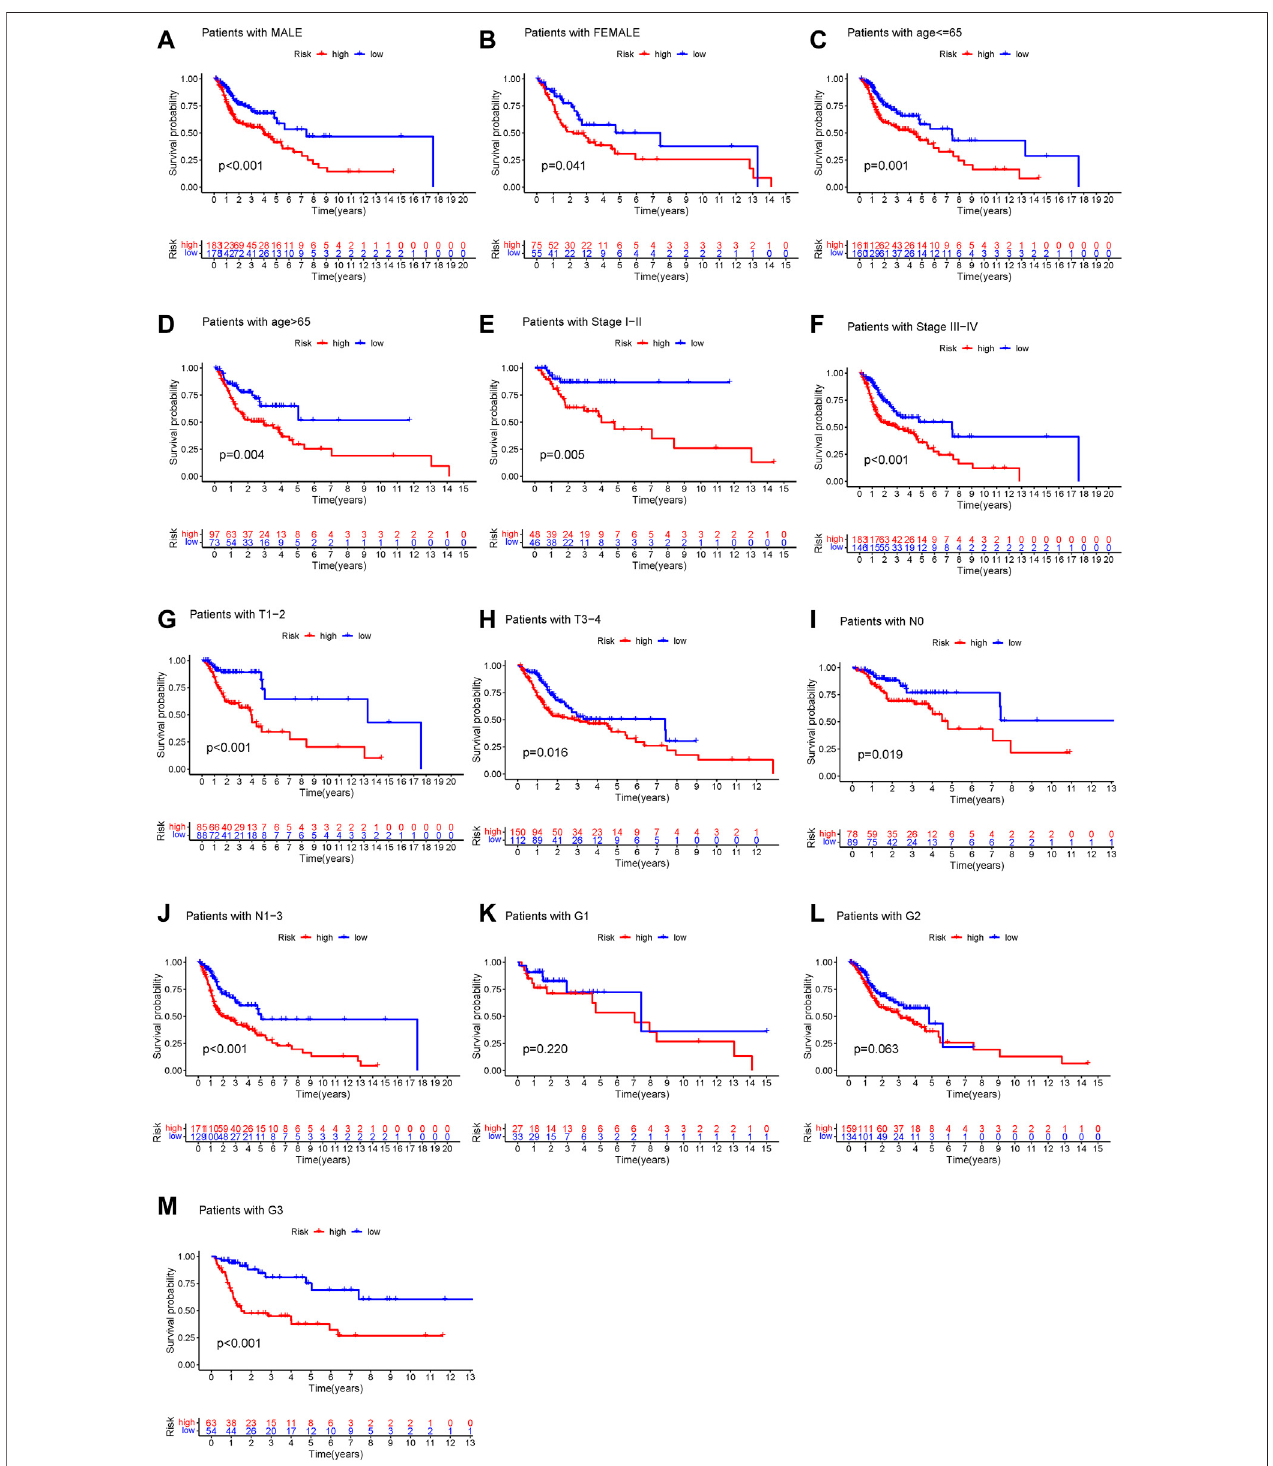
FIGURE 5 | Strati fi cation analysis of the genome instability-related lncRNAs signature. (A – M) Kaplan-Meier analysis of clinical subgroups based on the GILncSig scores. The clinical characteristics including: male (A) , female (B) , age ≤ 65 (C) , age > 65 (D) , stage I – II (E) , stage III – IV (F) , T1 – 2 (G) , T3 – 4 (H) , N0 (I) , N1 – 3 (J) , G1 (K) , G2 (L) , and G3 (M) .